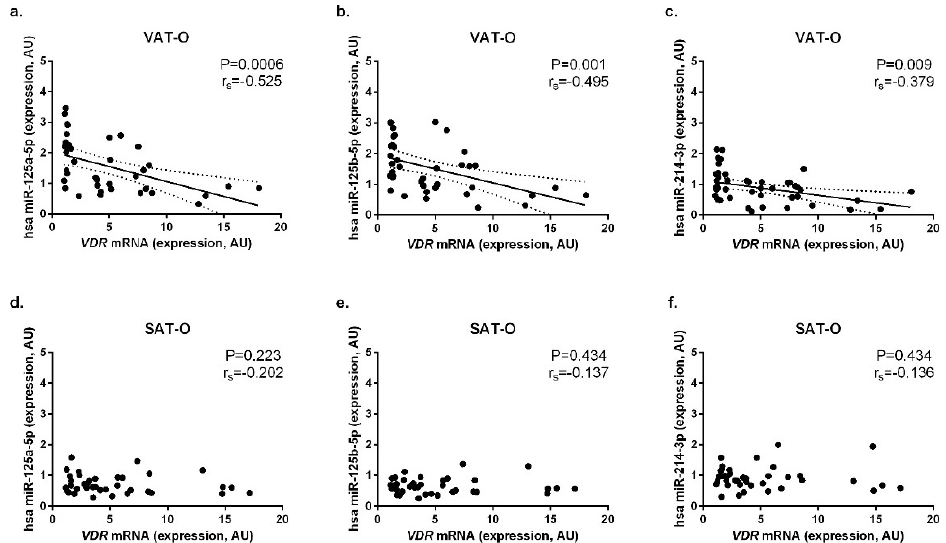
Figure 3. Correlation between mRNA levels of VDR and expression of hsa-miR-125a-5p, hsa-miR-125b-5p and hsa-miR-214-3p in visceral (VAT a – c , respectively) and subcutaneous (SAT d – f , respectively) adipose tissues of obese (O) individuals.